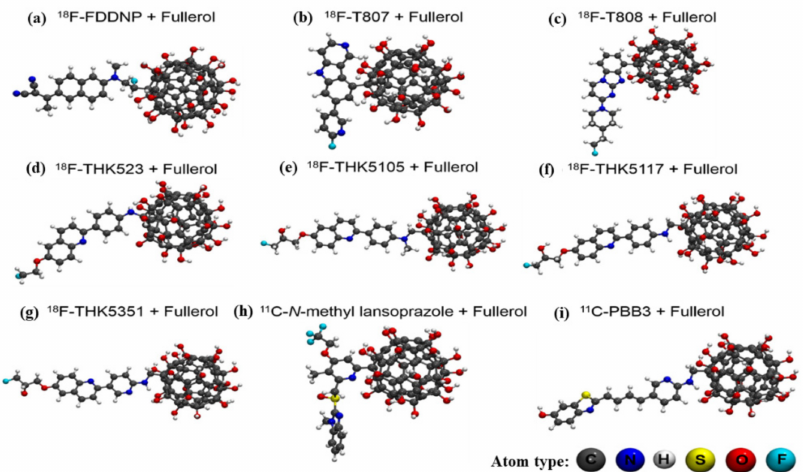
Figure 1. Optimized structures of the binary systems formed by the fullerol and the fluorescent radiopharmaceuticals systems used for the study of binding interactions with the paired helical filament (PHF)-tau protein as; ( a ) fullerol + 18 F-FDDNP, ( b ) fullerol + 18 F-T807, ( c ) fullerol + 18 F-T808, ( d ) fullerol + 18 F-THK523, ( e ) fullerol + 18 F-THK5105, ( f ) fullerol + 18 F-THK5117, ( g ) fullerol + 18 F- THK5351, ( h ) fullerol + 11 C- N -methyl Lansoprazole, and ( i ) fullerol + 11